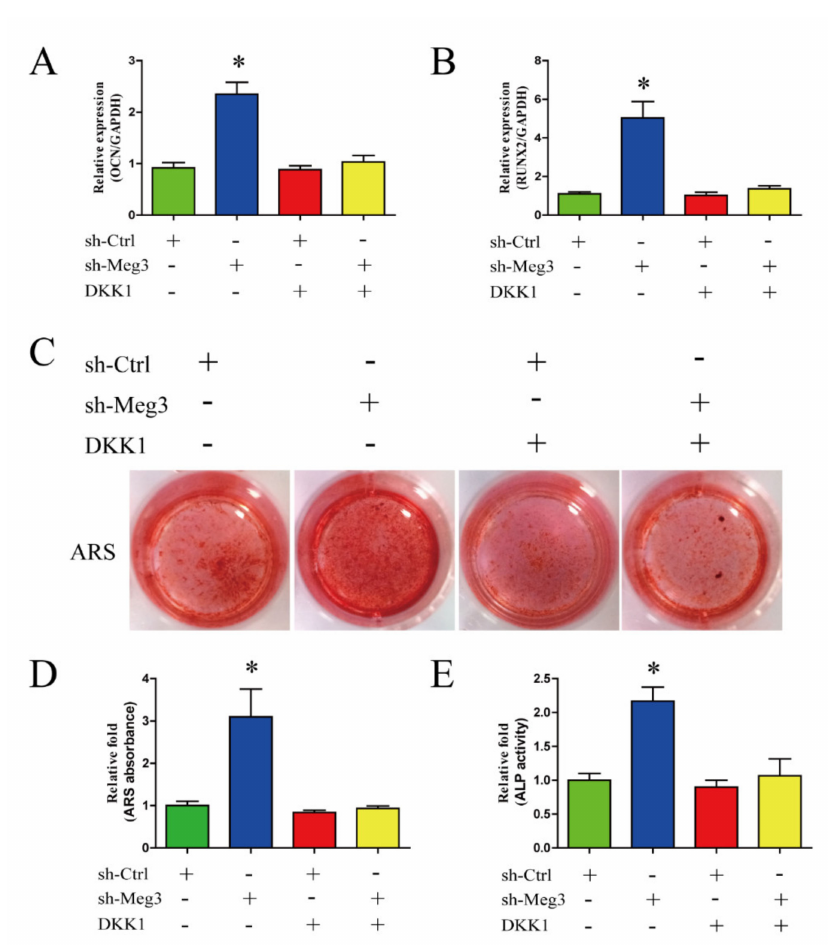
Figure 4. Wnt/ β -catenin inhibition impairs MEG3-induced osteogenesis of BMSCs. ( A ) sh-Ctrl and sh-Meg3 BMSCs were treated with or without Wnt/ β -catenin signaling inhibitor (DKK1). Bar graph shows the expression of OCN mRNA in sh-ctrl, sh-ctrl + DKK1, sh-Meg3 and sh-Meg3 + DKK1 groups. ( B ) Bar graph shows the expression of RUNX2 mRNA in sh-ctrl, sh-ctrl + DKK1, sh-Meg3 and sh-Meg3 + DKK1 groups. ( C ) Alizarin red staining in the sh-ctrl, sh-ctrl + DKK1, sh-Meg3 and sh-Meg3 + DKK1 groups at day 14 of osteogenic differentiation. ( D ) Alizarin red staining area in the sh-ctrl, sh-ctrl + DKK1, sh-Meg3 and sh-Meg3 + DKK1 groups determined by measuring the absorbance at 560 nm. ( E ) Bar graph shows expression of ALP in sh-ctrl, sh-ctrl + DKK1, sh-Meg3 and sh-Meg3 + DKK1 groups. Data are presented as mean ± SD. * p < 0.05 versus the sh-ctrl group ( n =